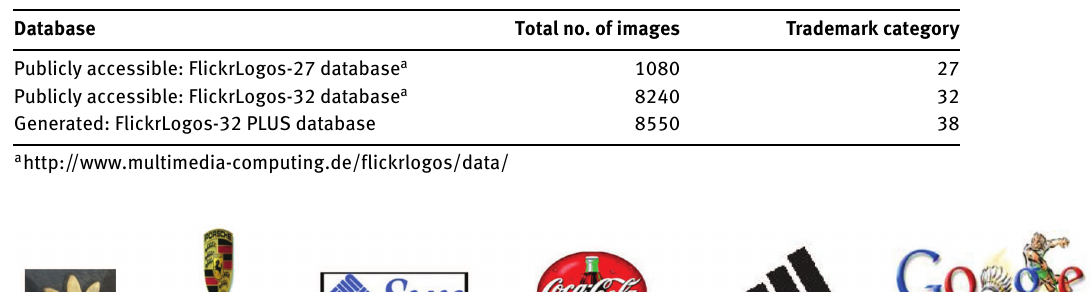
Table 1: Trademark Databases Used for Experimentation.